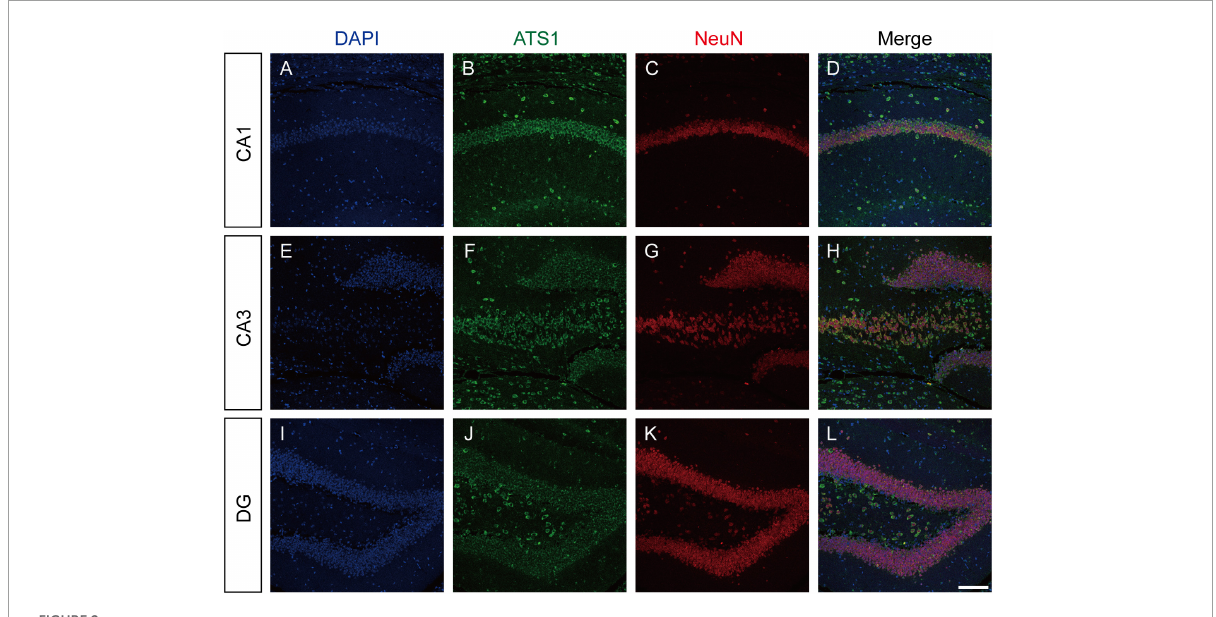
FIGURE2 ATS1 was mainly expressed in neurons. (A,E,I) Nuclei were labeled by DAPI in CA1, CA3, and DG regions. (B,F,J) ATS1 was labeled by anti-ATS1 antibody in CA1, CA3, and DG regions. (C,G,K) Neurons were labeled by anti-NeuN antibody in CA1, CA3, and DG regions. (D,H,L) The merged images of DAPI, ATS1, NeuN revealed that neurons were the predominant source of ATS1. Scale bars, 100 µ m. ATS1, ADAMTS1. DG, dentate